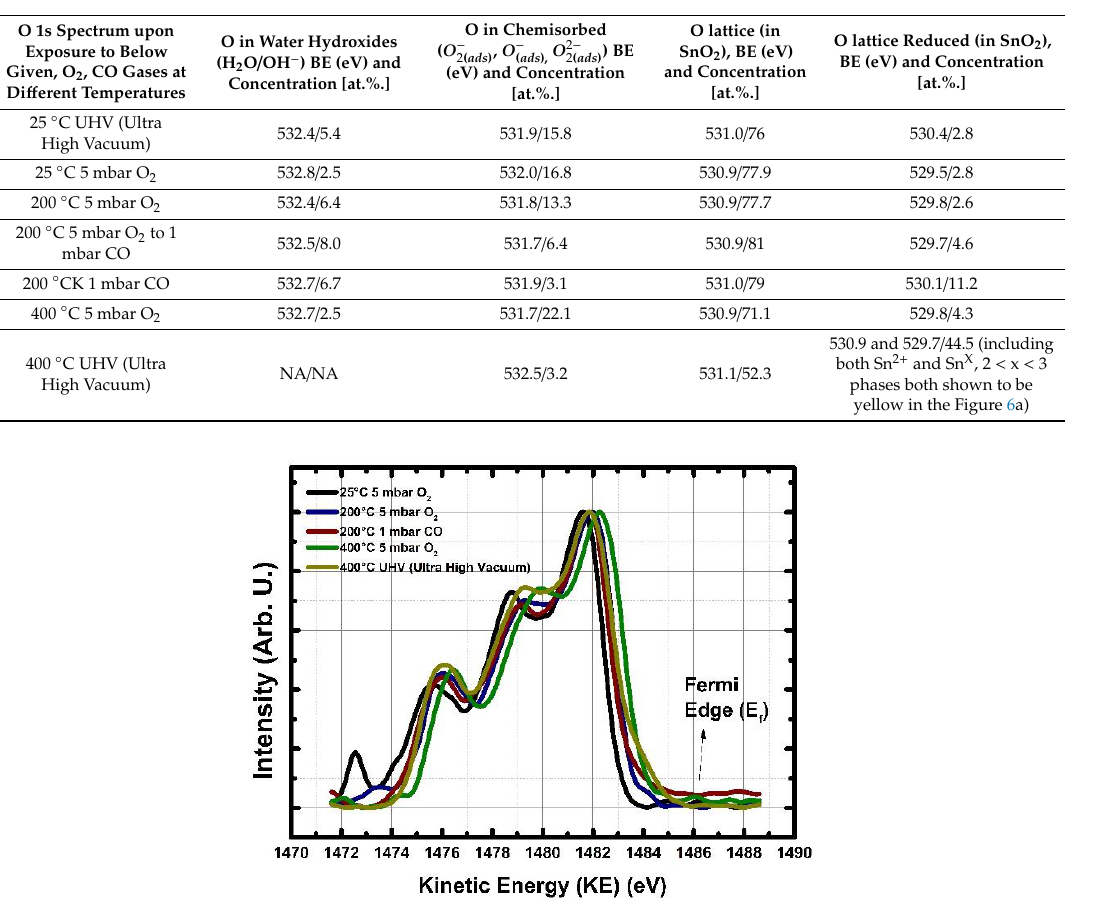
Figure 7. Valance band spectrum of the SnO 2 thin film as a function of O 2 and CO exposures and temperature.